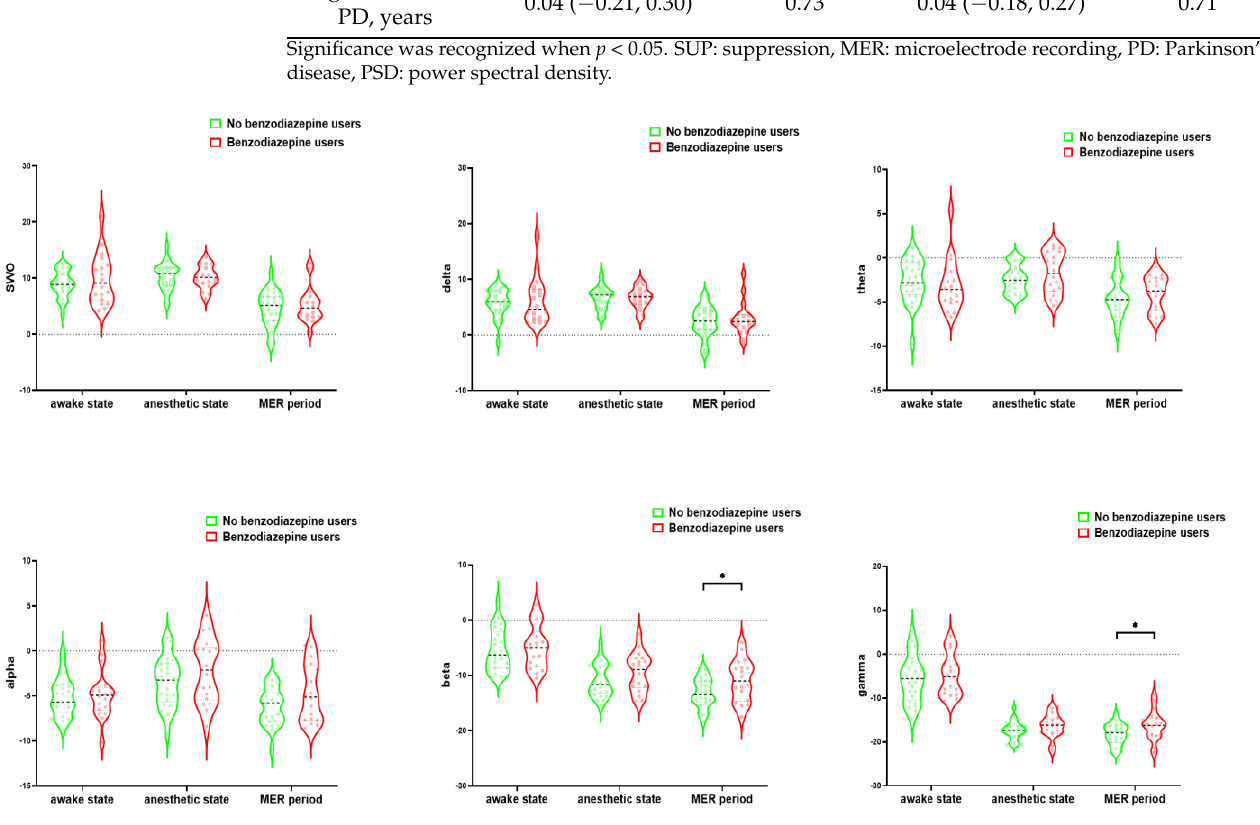
Figure 5. The violin diagram shows the average power spectral density of each frequency band in three states. The mean power spectral density was significantly different between the two groups in the beta and gamma bands during MER (no benzodiazepine users vs. benzodiazepine users, mean ± SD; beta: − 13.20 ± 2.65 vs. − 10.92 ± 3.78, p = 0.03; gamma: − 18.28 ± 2.38 vs. − 16.24 ± 3.37, p = 0.03). SWO (0.2–1.5 Hz), delta (1.6–3 Hz), alpha (8–12 Hz), beta (13–39 Hz), gamma (40–80 Hz). SWO: slow-wave oscillation, MER: microelectrode